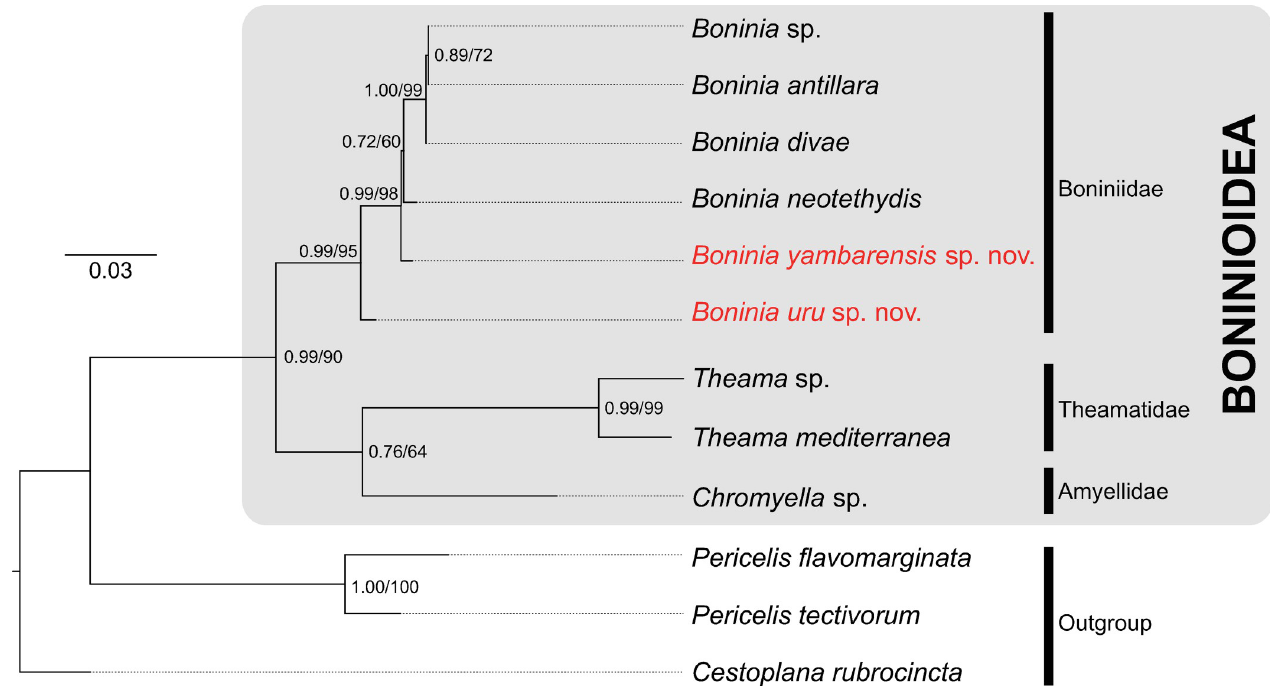
Fig 7. Maximum likelihood phylogenetic tree based on a concatenated dataset of partial 18S and 28S. Numbers near nodes are posterior probability and bootstrap values, respectively.